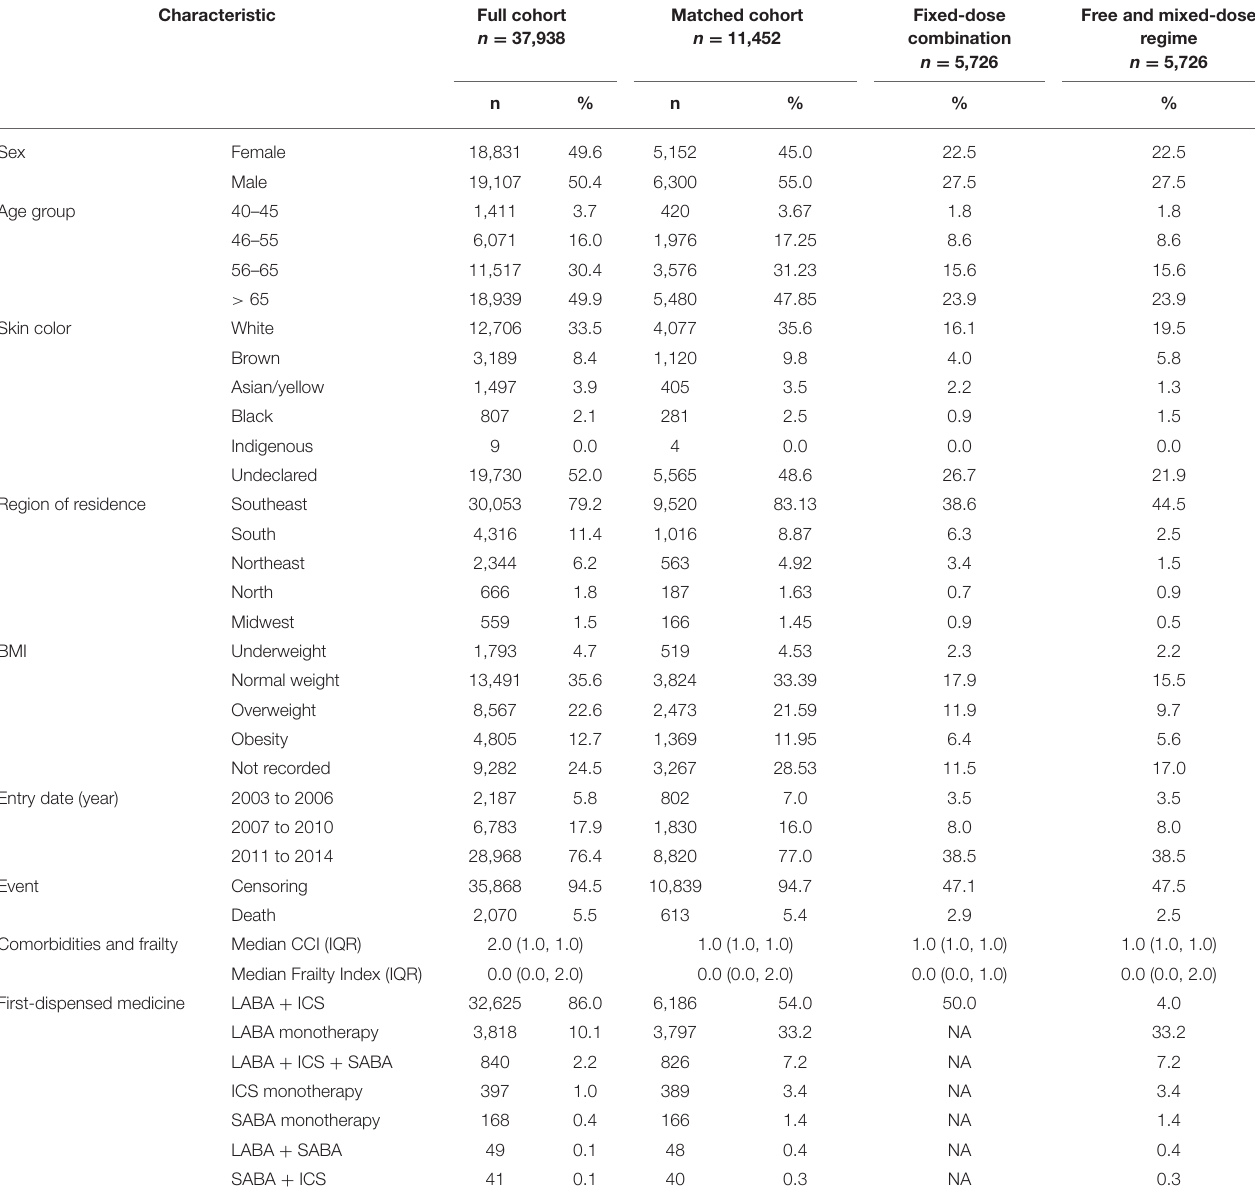
TABLE 1 | Baseline characteristics of patients included in the Cohort from 2000 to 2015.